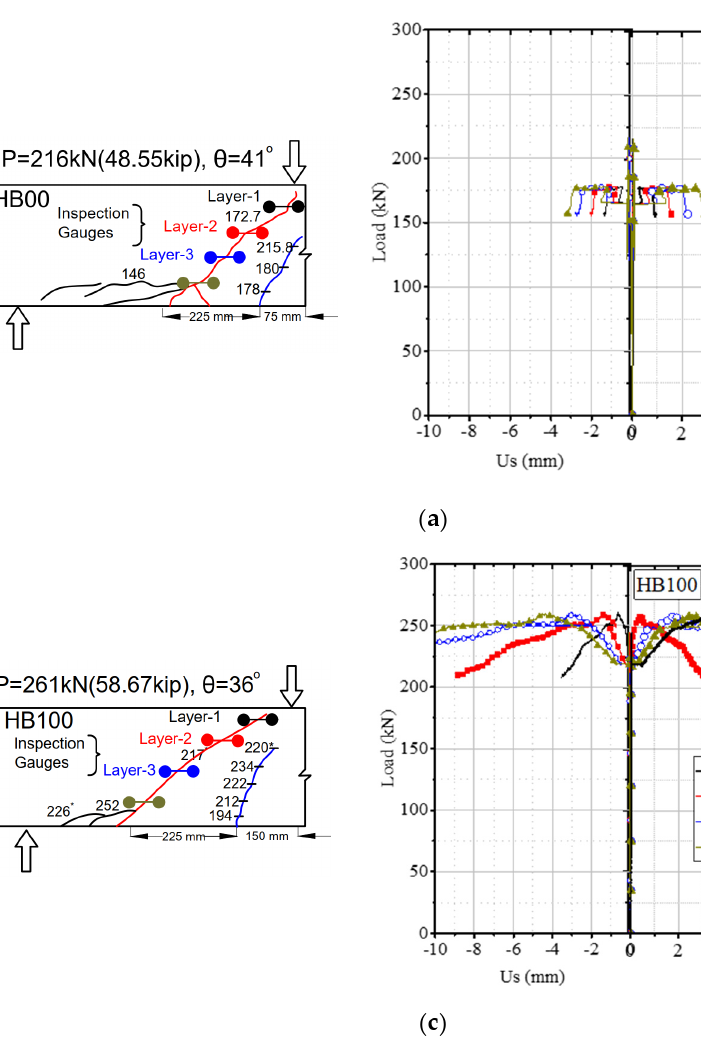
Figure 11. Failure mode and crack slip ( U s ) and crack opening ( U w ) with respect to load: ( a ) HB00; ( b ) HB50, ( c ) HB100, ( d ) HB150, * = post peak loads.